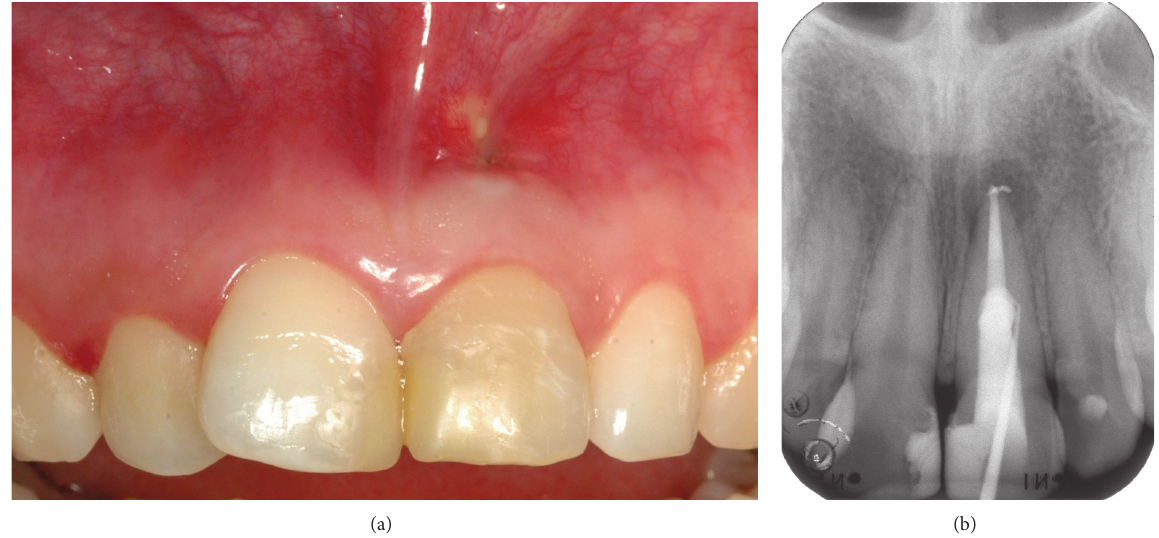
Figure 6: (a) Discoloration of the mucosa at the site of the perforation. (b) Radiograph showing the persistence of the coronal fistula.